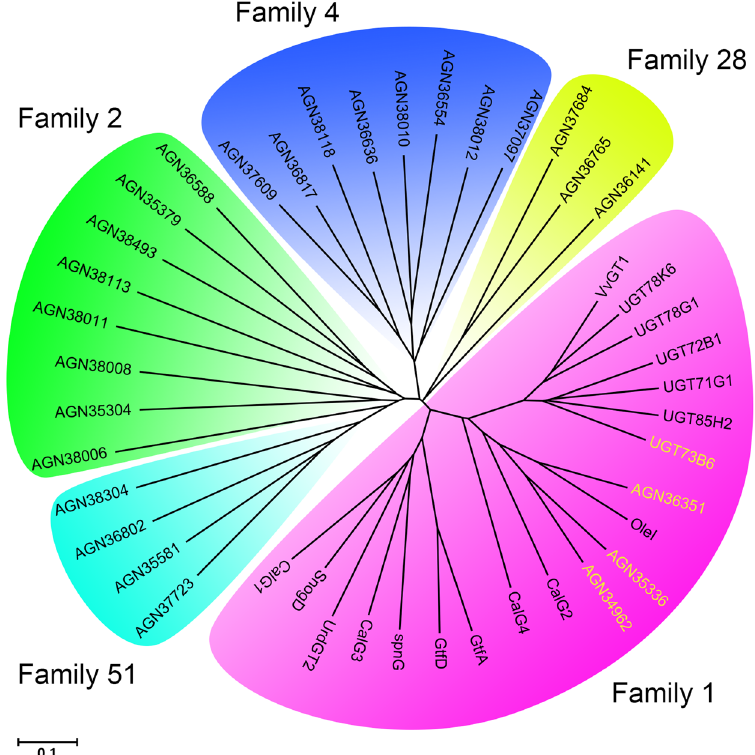
Figure 2. The phylogenetic tree of glycosyltransferases PSPG